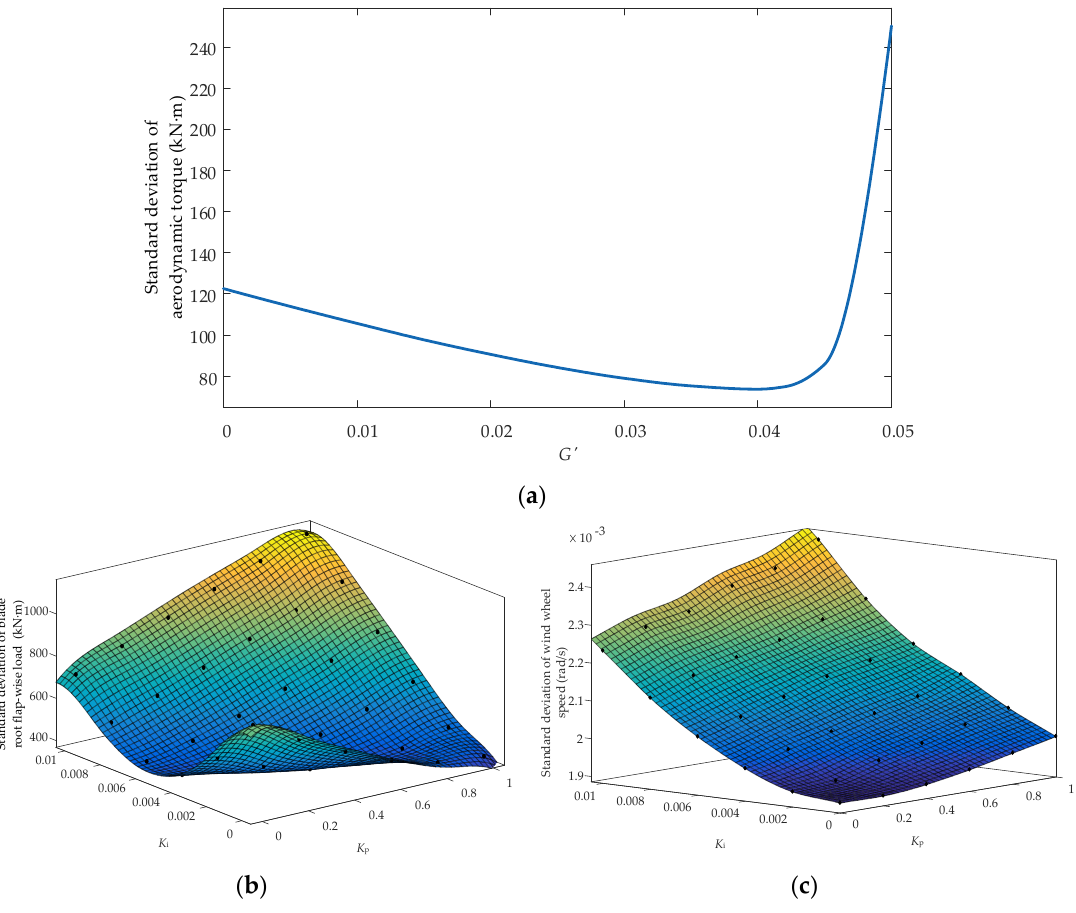
Figure 10. Control performance with different pitch control parameters: ( a ) Standard deviation of aerodynamic torque at different G ' ; ( b ) Standard deviation of blade root flap-wise load at different K p , K i ; ( c ) Standard deviation of wind wheel speed at different K p , K i .